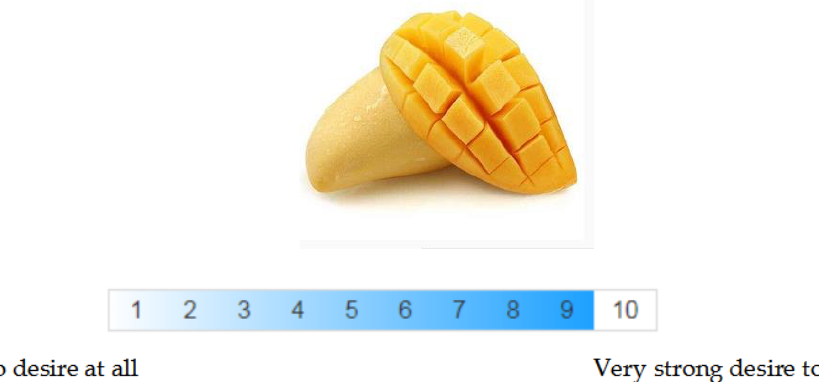
Figure A6. The picture of black bean products (Liquid food).